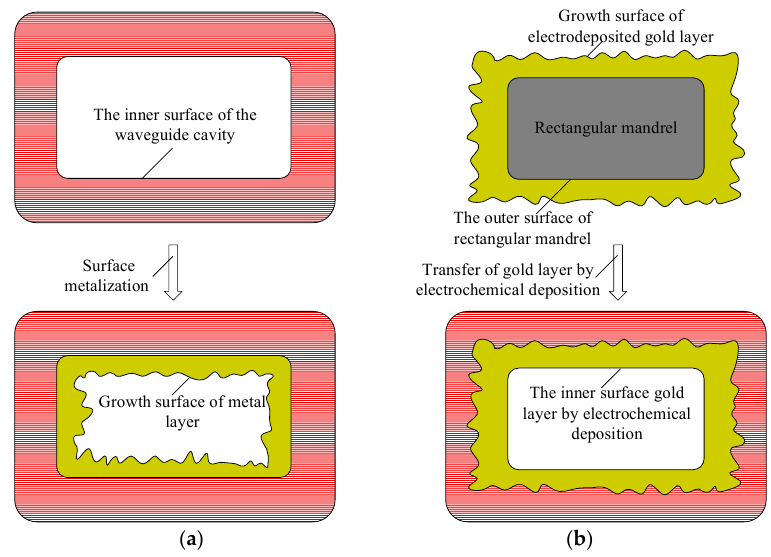
Figure 3. Comparison of the working surface of the metal layer inside the waveguide cavity between the original method and the presented method in this paper: ( a ) the original method, ( b ) the presented method in this paper.